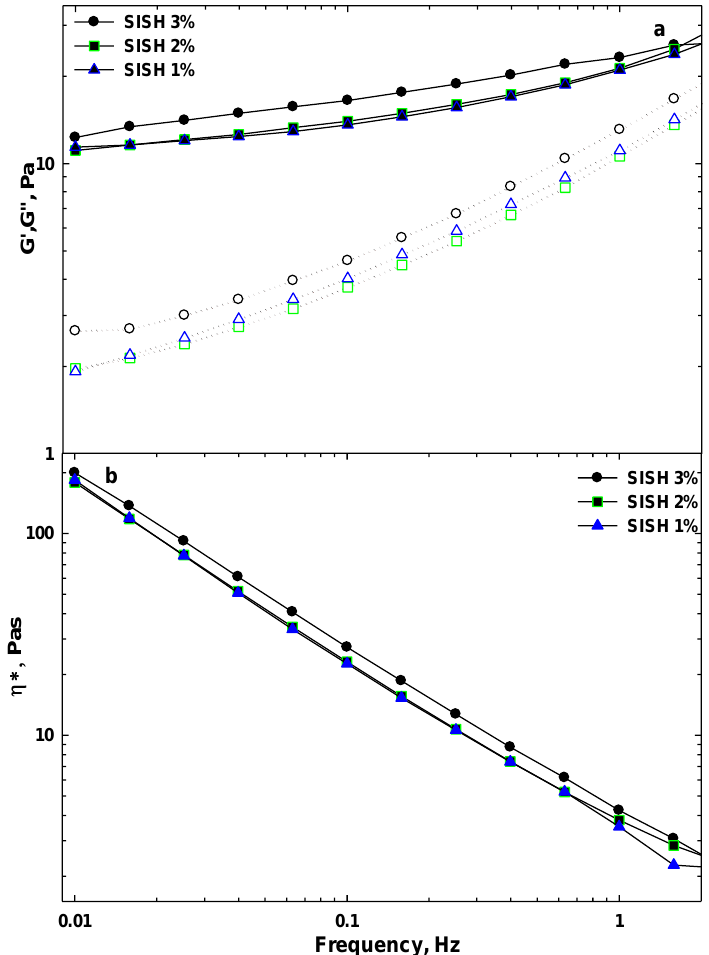
Figure 3. Viscoelastic modulus ( a ) and complex viscosity ( b ) of SISH dispersions at different con- centrations (1, 2, and 3%) determined by frequency sweep tests from 0.01 to 2 Hz with the strain amplitude of 0.5%.